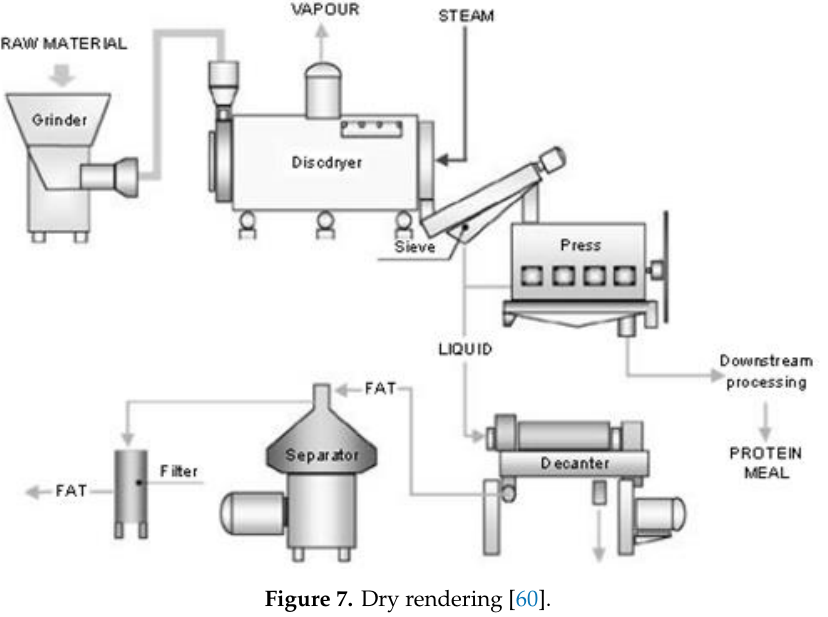
Figure 7. Dry rendering [60].